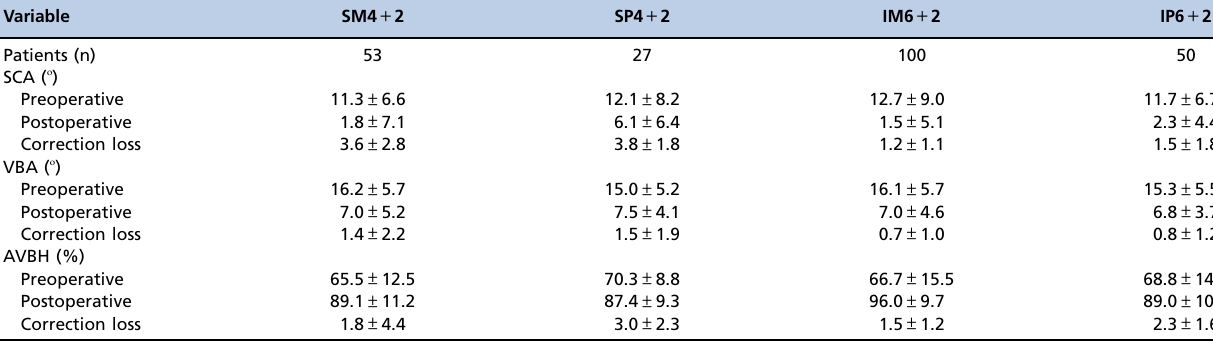
Table 2 - Radiological assessment of the deformity correction [Mean ± SD].